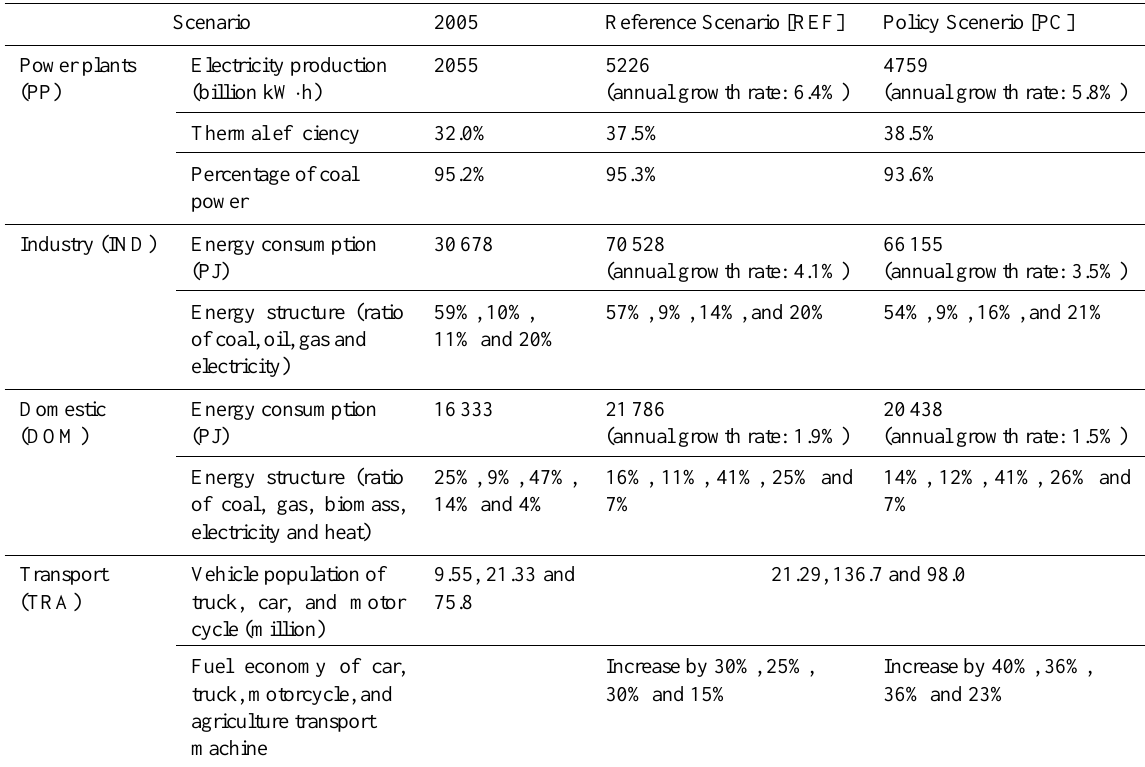
Table 1. Key parameters used in the development of energy